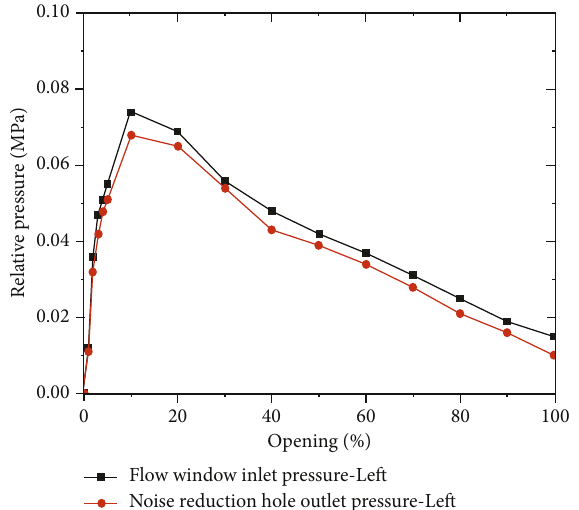
Figure 19: Left flow window noise reduction orifice inlet and outlet velocity-opening curve.